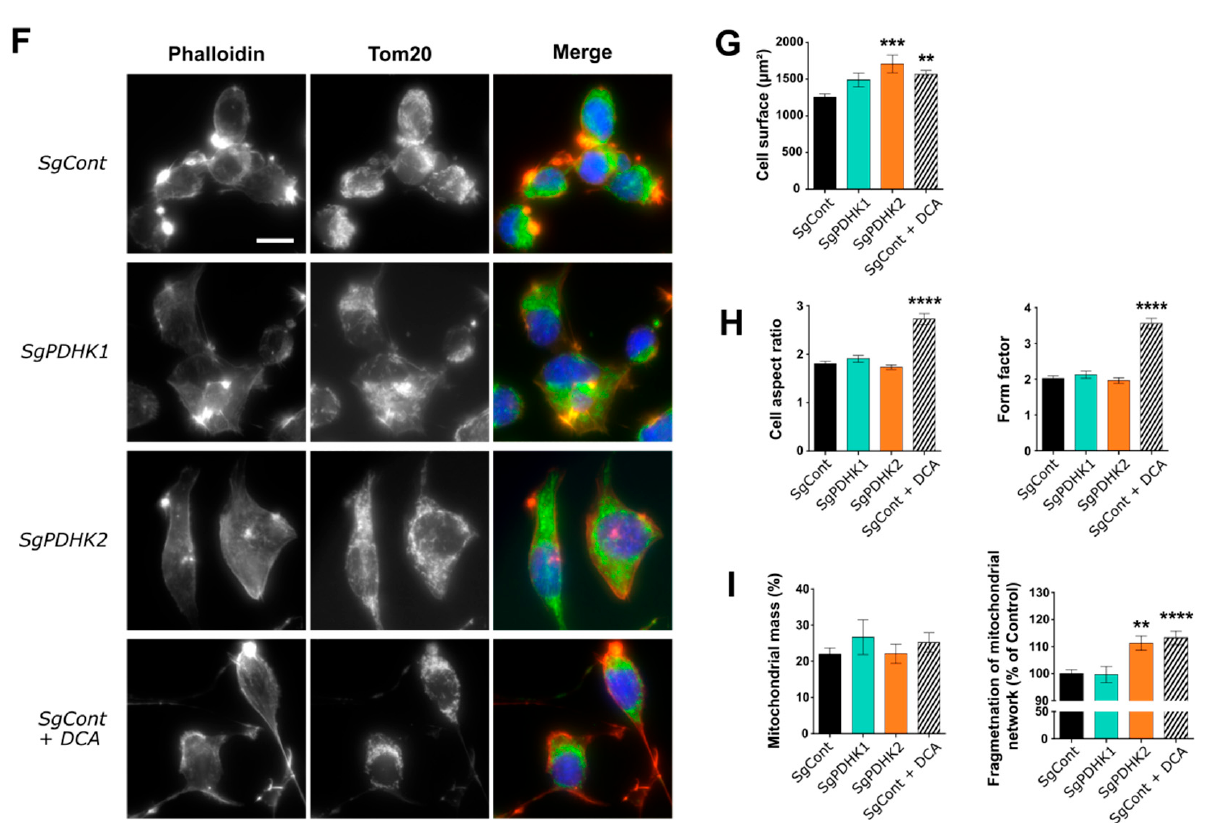
Figure 2. Dichloroacetate (DCA) reduces levels of phosphorylated PDH in a primary glioblastoma in vitro cell model, impacting cell and mitochondrial organization. ( A ) Illustration of the two alter- native pyruvate utilization pathways and the impact of PDHK activity on the balance between lactic fermentation or mitochondrial oxidation of pyruvate. ( B – E ) Western blotting and corresponding quantification of PDHK1, PDHK2 expression or phospho-PDH status in P3 cells control, knockout for PDHK1, PDHK2 or treated with DCA 25 mM for 3 days; all cells were exposed to either 21% O 2 or 0.1% O 2 . Graphs represent densitometry quantification normalized with vinculin ( n = 3 or 4). ( F ) Epifluorescence images of immunofluorescence stainings on P3 SgCont, SgPDHK1, SgPDHK2 or treated with DCA 25 mM for 3 days (Phalloidin, red; Tom20, green; Hoechst, blue). Scale bar: 20 µ m. ( G , H ) Immunofluorescence image analysis (120 to 240 cells per group): ( G ) cell surface quantification; ( H , left ) cell aspect ratio corresponding to the ratio of the major axis to minor axis of the cells; ( H , right ) form factor imaging branching of the cells. ( I ) Mitochondrial network analysis based on immunofluorescence pictures; ( left ) mitochondrial mass expressed as the percentage of total cell area (39 to 99 cells per group); ( right ) quantification of mitochondrial network fragmentation corresponding to the ratio of the number of mitochondria per cell on the area of the full mitochondrial network, normalized by the mean of control group and expressed as the percentage of control. Data are expressed as the mean ± SEM and p -values were obtained using one-way ANOVA ( D , G , H , I left ) or unpaired t -tests ( C , E , I right ); * p < 0.05; ** p < 0.01; *** p < 0.001; **** p < 0.0001; ns. : not significant. Cell morphology analysis showed that PDHK2 KO and DCA-treated cells increased in size. DCA-treated cells were also found to be more elongated, as shown by an increase in aspect ratio and form factor parameters (Figure 2F–H), correlating with a higher number of microtubes (Figure 2F, lower panels), membrane structures that have been described previously [24]. Finally, the mitochondrial network was analyzed based on anti-Tom20 staining and no difference was observed in the mitochondrial mass between conditions, but the mitochondrial networks appeared more fragmented in PDHK2 KO and DCA-treated cells (Figure 2I), indicating mitochondrial